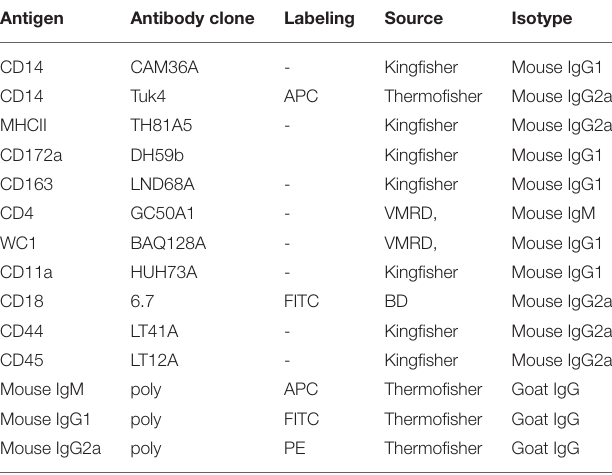
TABLE 1 | List of monoclonal and polyclonal antibodies. Antigen Antibody clone Labeling Isotype